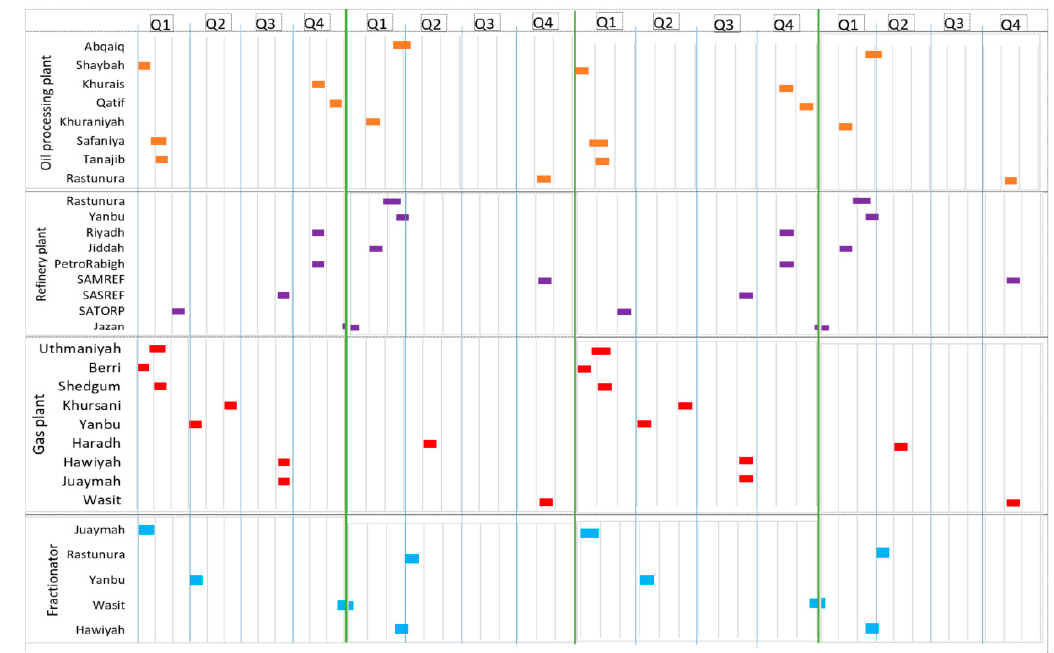
Figure 11. Maintenance schedule for all HCSC plants (reducing the storage capacity of upstream petroleum plants by 50%); Color code: Orange: oil processing plants; Purple: Refinery plants; Red: Gas plants; Light Blue: Fractionator plants.